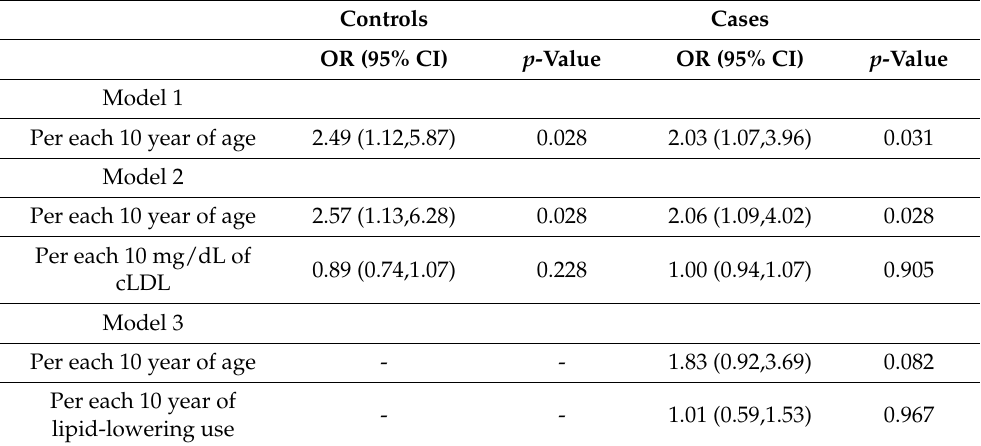
Table 2. Influence of age, LDL-cholesterol, and years under statin treatment on cataract surgery in controls and in